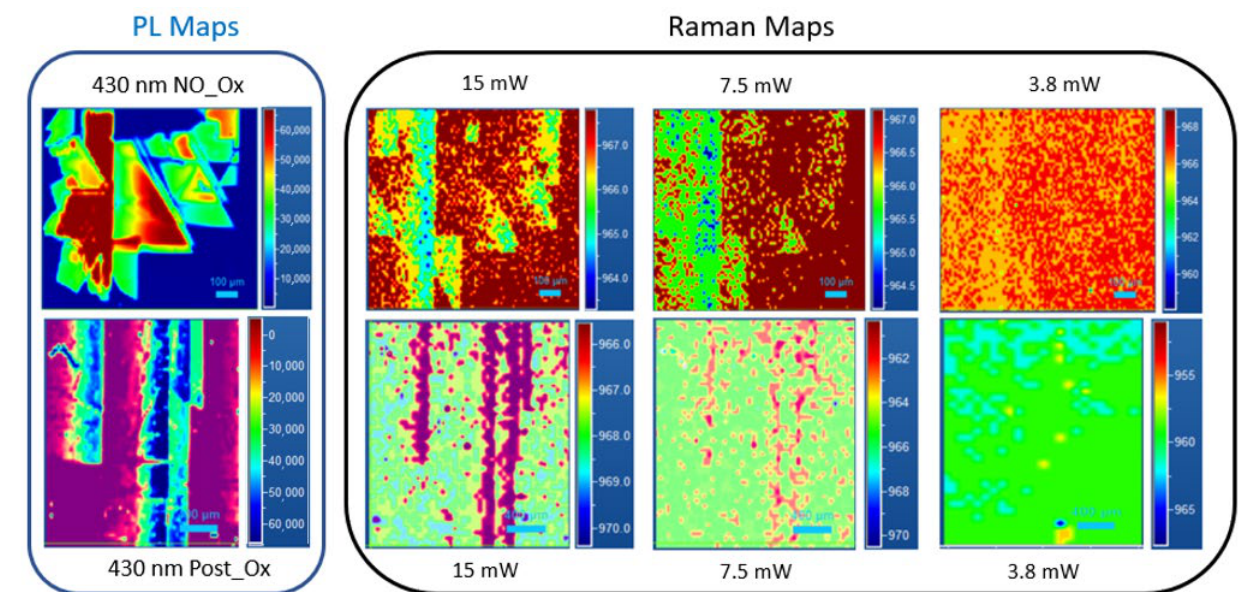
Figure 6. PL and Raman maps of an isolated defect at 430 nm No_Ox (upper strip) and Post OX (lower strip) for different induced carrier values related to the laser power used (15–7.5–3.8 mW, respectively) following the LO peak position.